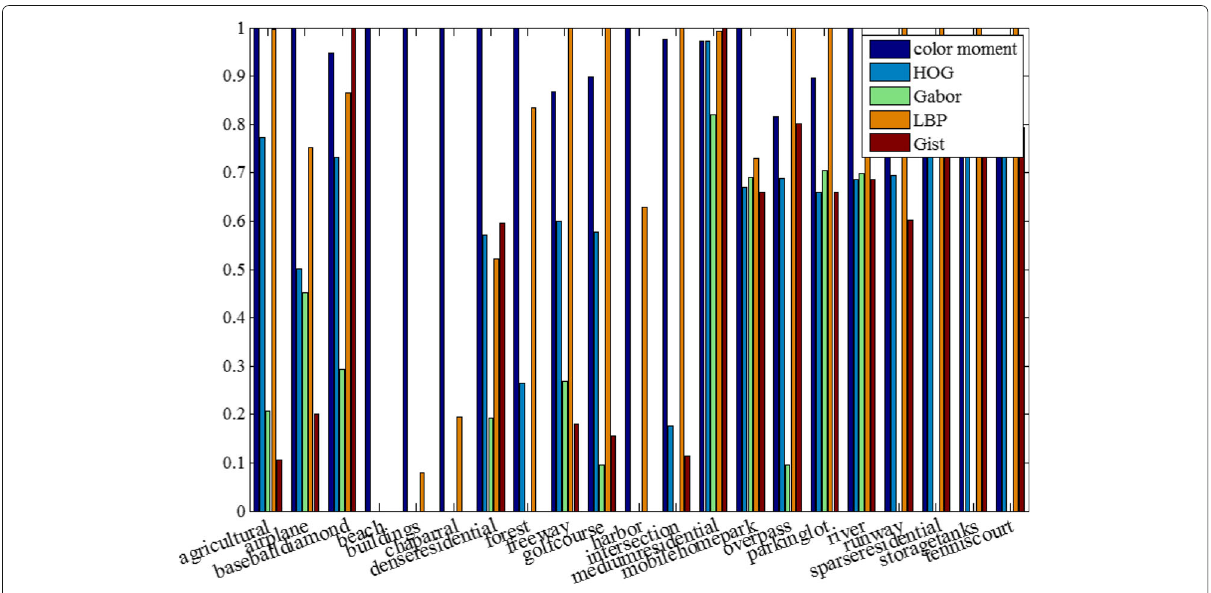
Fig. 8 Relative contribution ratios of features for each class of USGS21